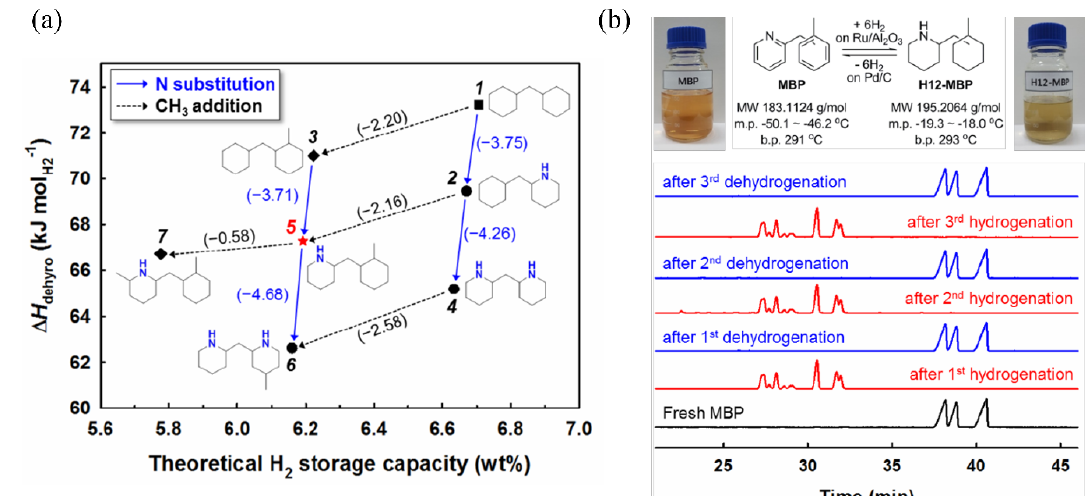
Figure 12. The schematic illustration of the perhydro-2-( n -methylbenzyl pyridine)/2-( n -methylbenzyl pyridine) LOHC system.